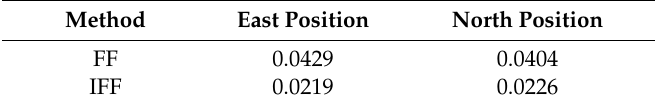
Figure 7. Curves of the east and north position errors for the fading filter (FF) and the IFF. Table 4. Position (m) root-mean-square error (RMSE) for the FF and the